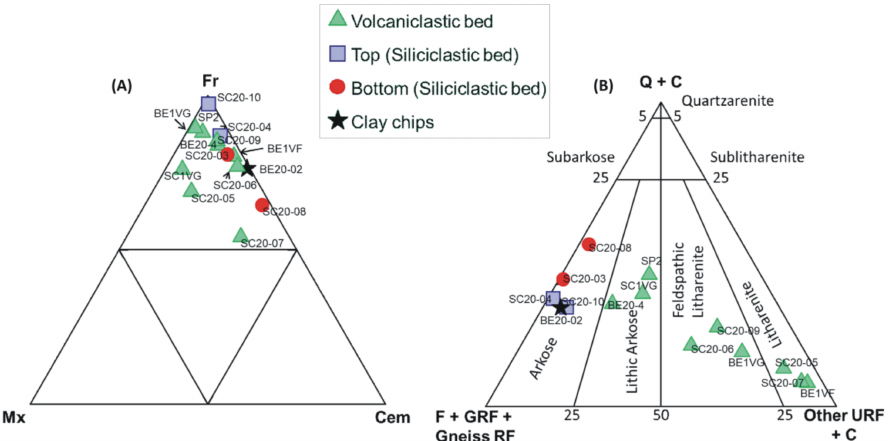
Figure 3. ( A ) Relative proportions of Framework: Matrix:Cement. Framework (Fr): total detrital grains: Matrix (Mx): Siliciclastic + Carbonate matrix; Cement (Cem): Carbonate cement + Oxid-Fe cement. See Table 1 for the abbreviations. ( B ) Traditional sandstone classifications after [59].